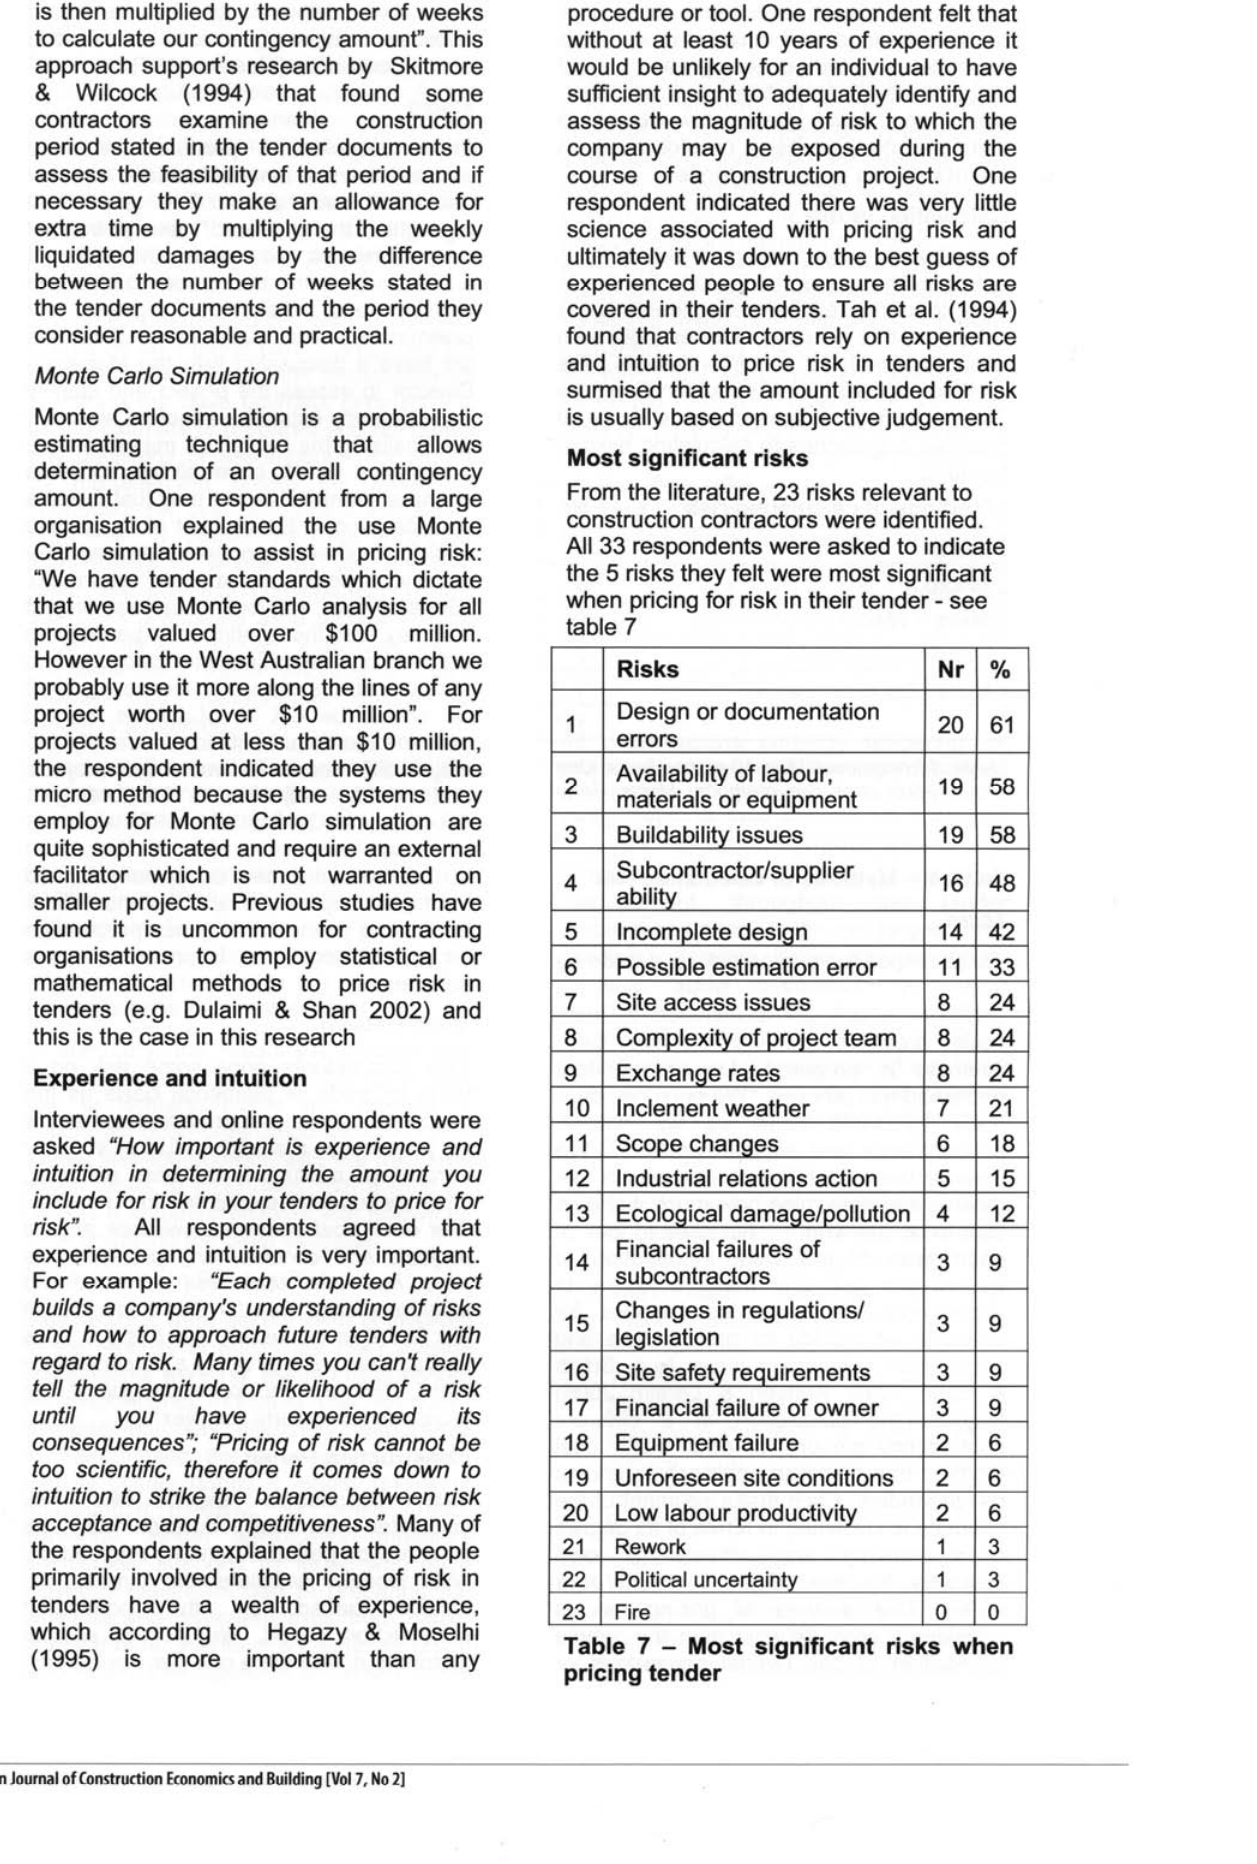
Table 7 - Most significant risks